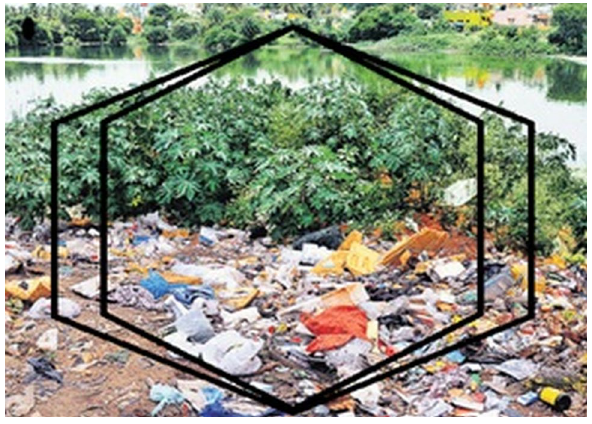
Fig. 2 Soil contamination caused by human